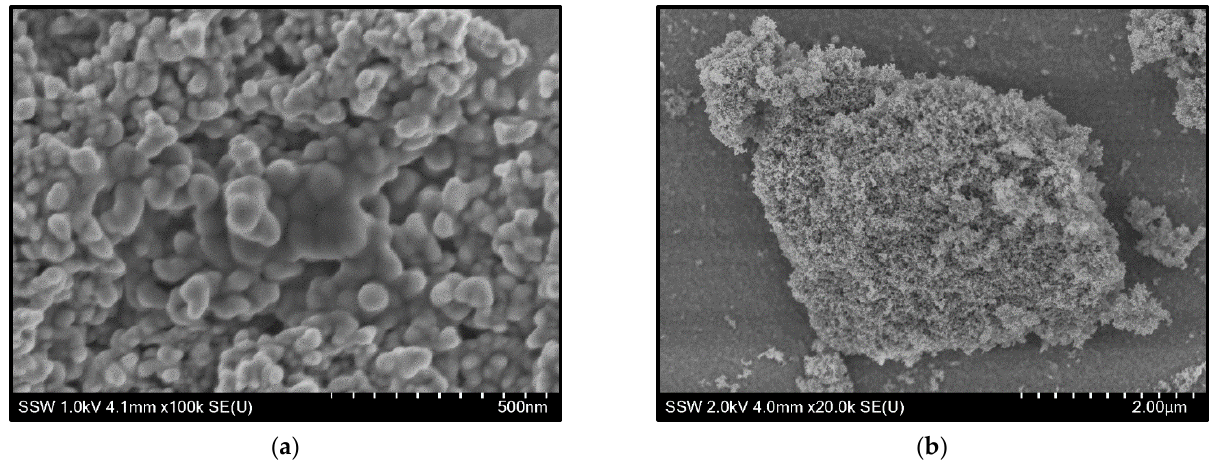
Figure A1. Scan Electron Microscope images for the 0.25 wt% Pd-TiO 2 photocatalyst at two different accelerating voltages: ( a ) 1.0 kV; and ( b ) 2.0 kV.